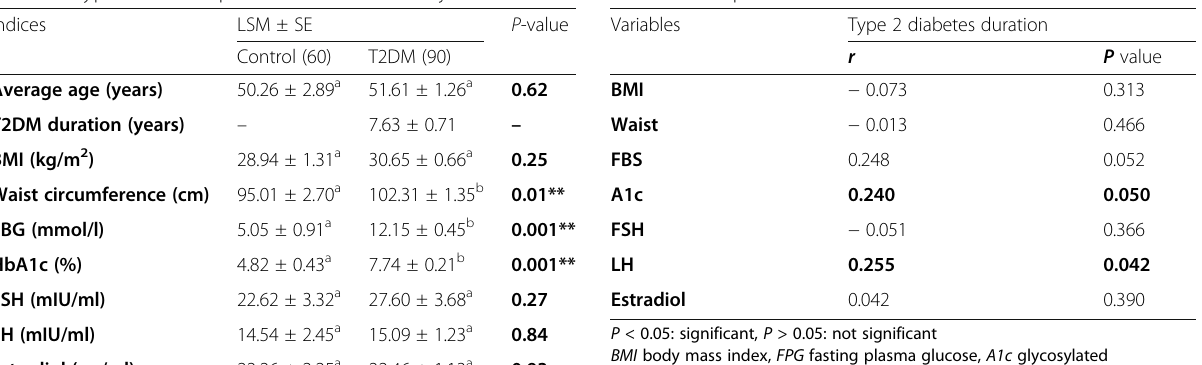
Table 7 Correlation between type 2 diabetes duration and other clinical parameters